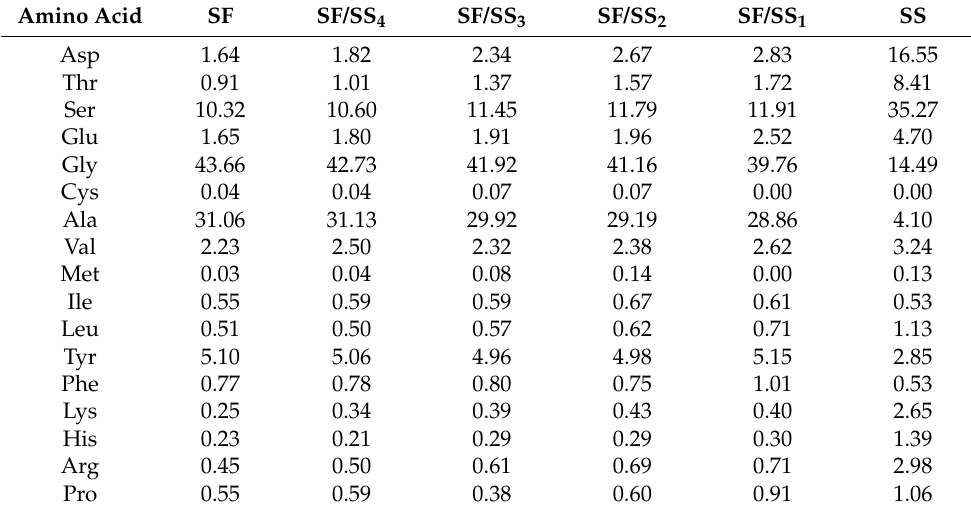
Table 2. Amino acid composition of SF/SS composites solutions